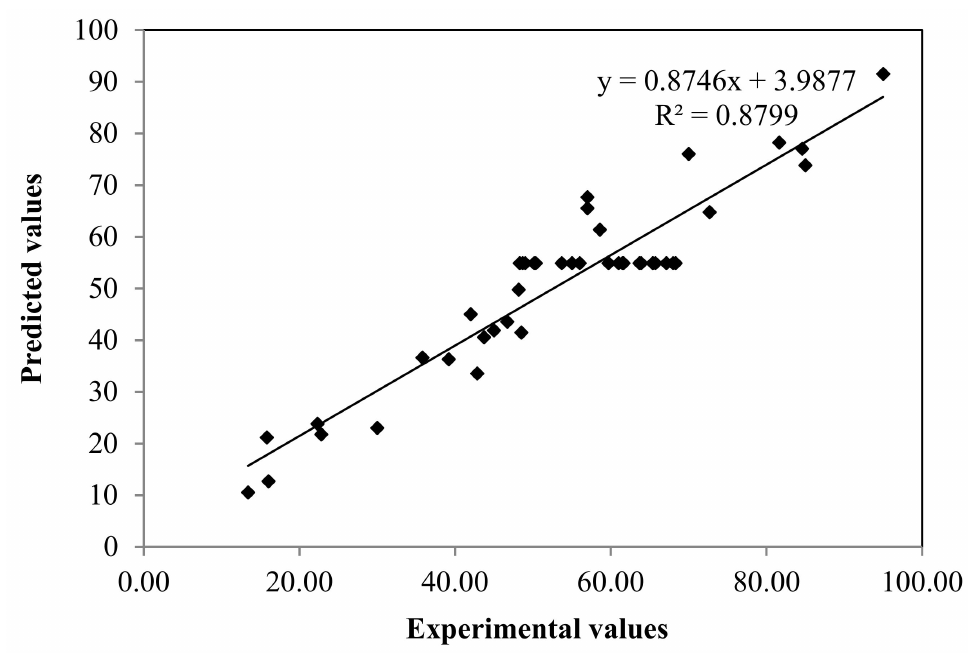
Figure 2. Predicted vs. actual values plot for color removal.